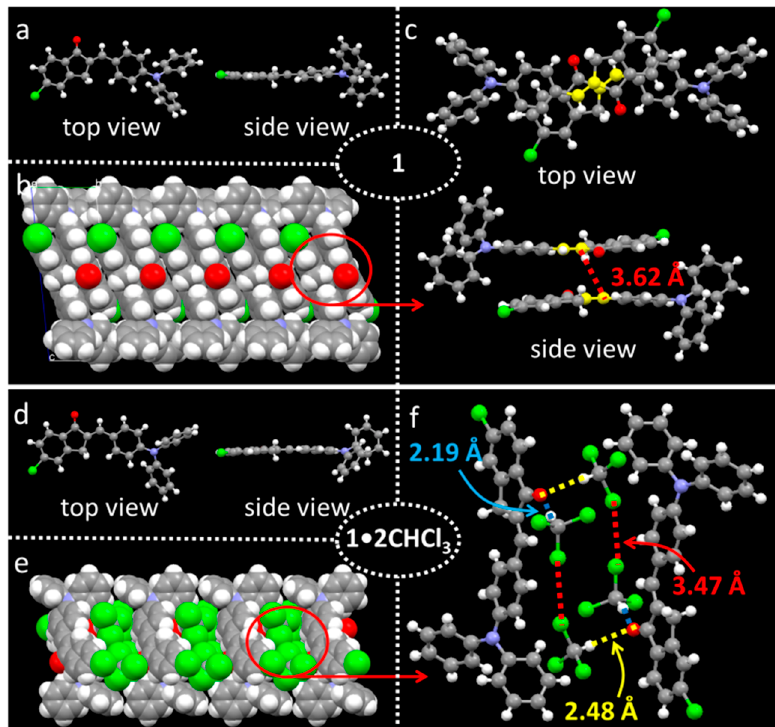
Figure 4. Crystal structures of the pure crystal phase 1 ( a – c ) and the co-crystal phase 1•2CHCl 3 ( d – f ): ( a ) top view and side view of the molecule; ( b ) special “molecular pairs” packing mode along crystallographic b diresction; ( c ) side view and top view of the “molecular pair” with short distance between the two vinyl groups (marked in yellow); ( d ) top view and side view of the molecule; ( e ) “molecular pairs” packing structure along crystallographic b direction with large amounts of CHCl 3 filling in the crystal and ( f ) strong interactions between the two molecules of compound 1 and four CHCl 3 molecules.